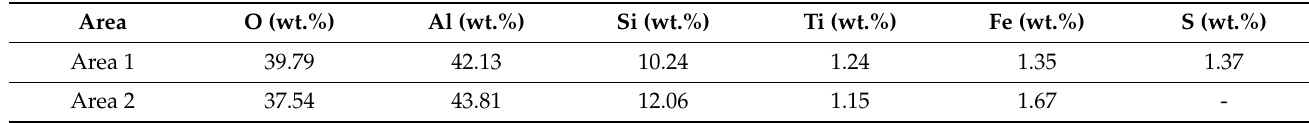
Table 5. Elemental analysis results of area 1 and area